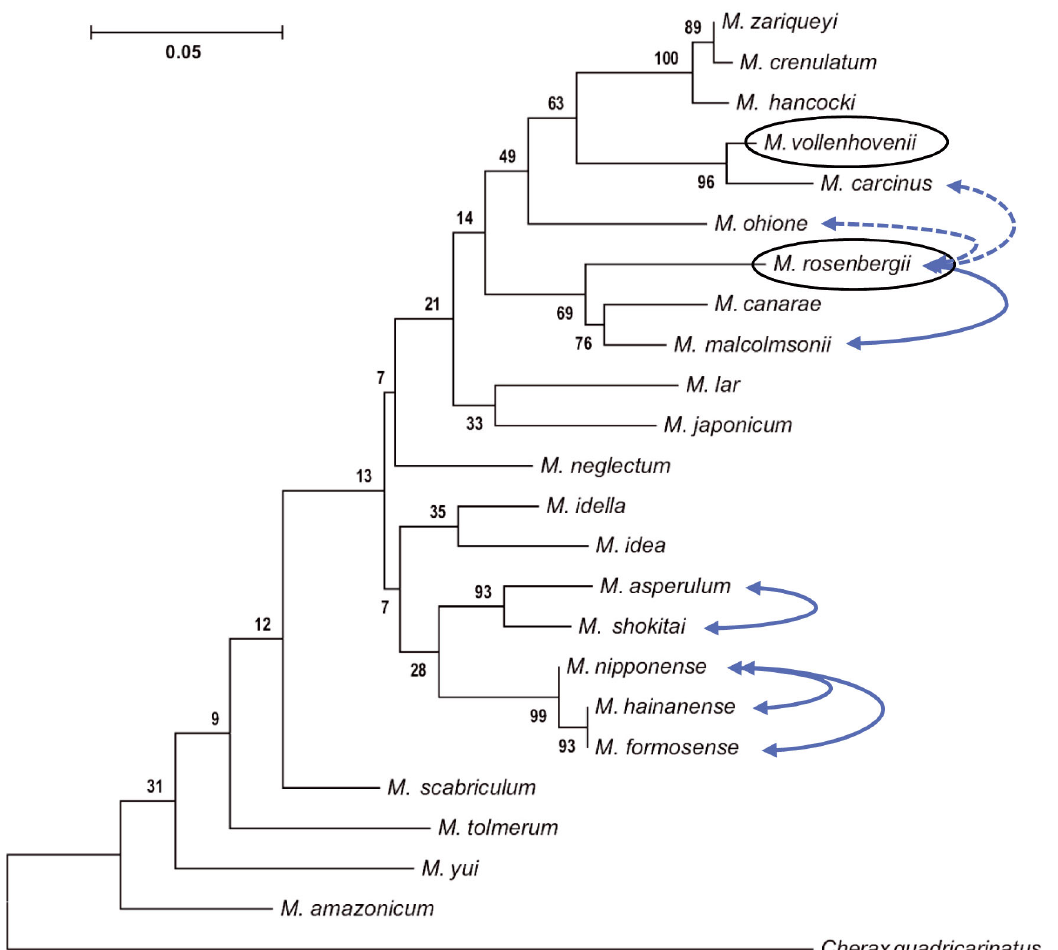
Fig. 6. Evolutionary relationships of 23 Macrobrachium species according to mitochondrial 16S gene. M. rosenbergii and M. vollenhovenii are shown in black circles. Solid and dashed arrows between different species represent successful and unsuc- cessful cross-species hybridization attempts,